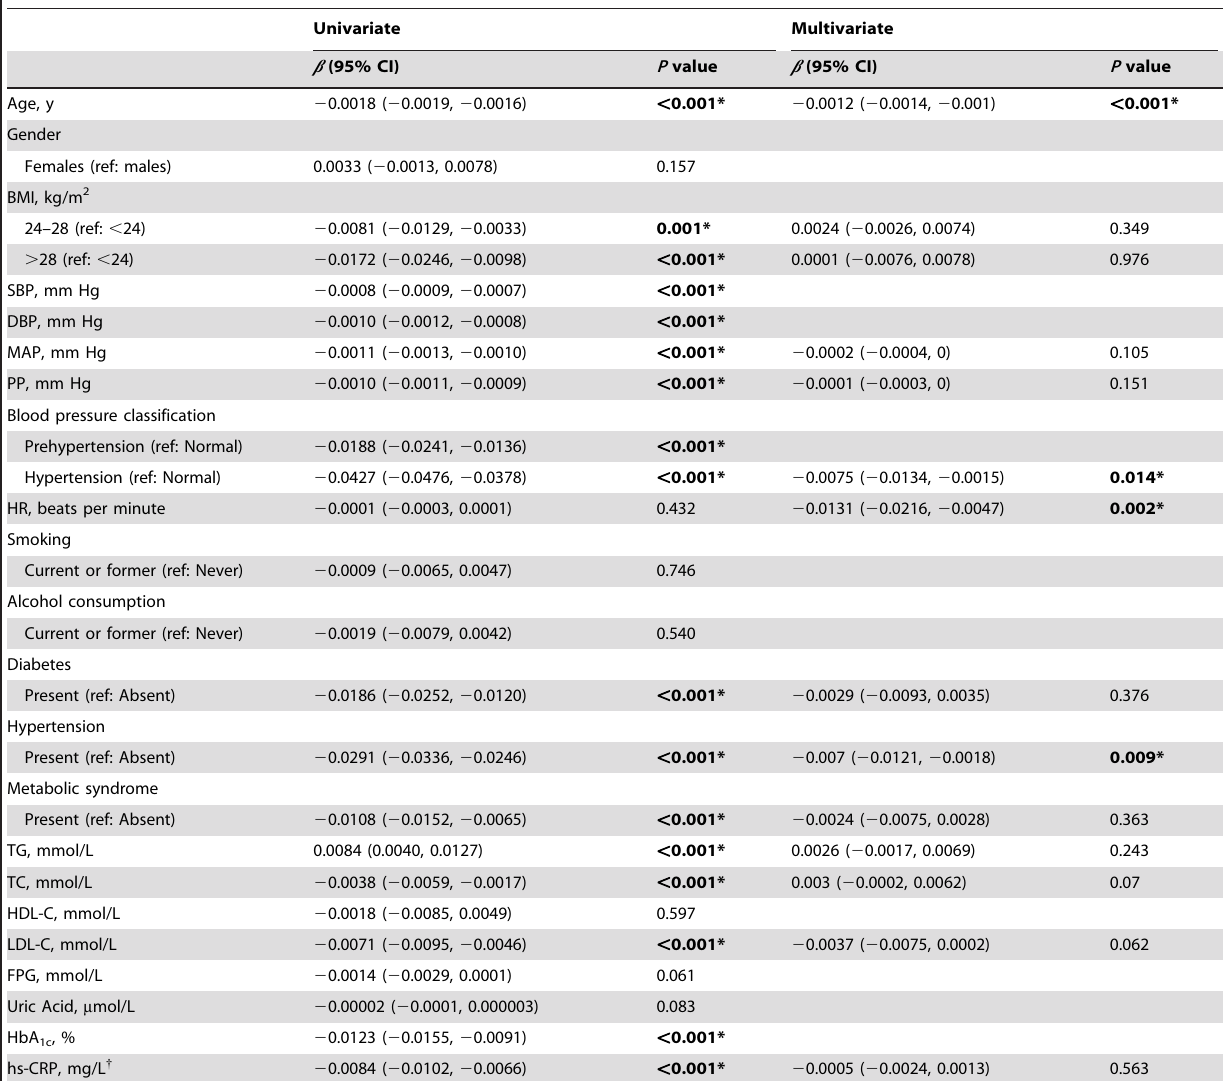
Table 5. Simple and multiple linear regression analyses for